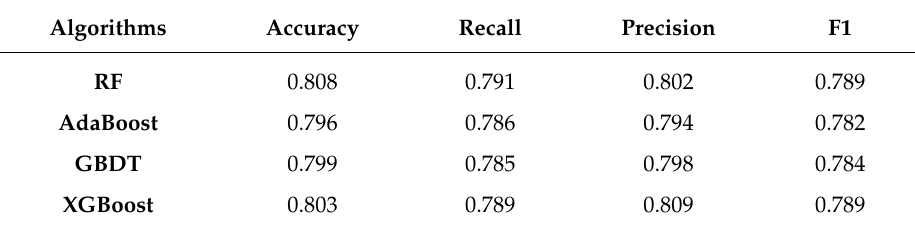
Table 11. Results of step identification within an action on the UnionPay